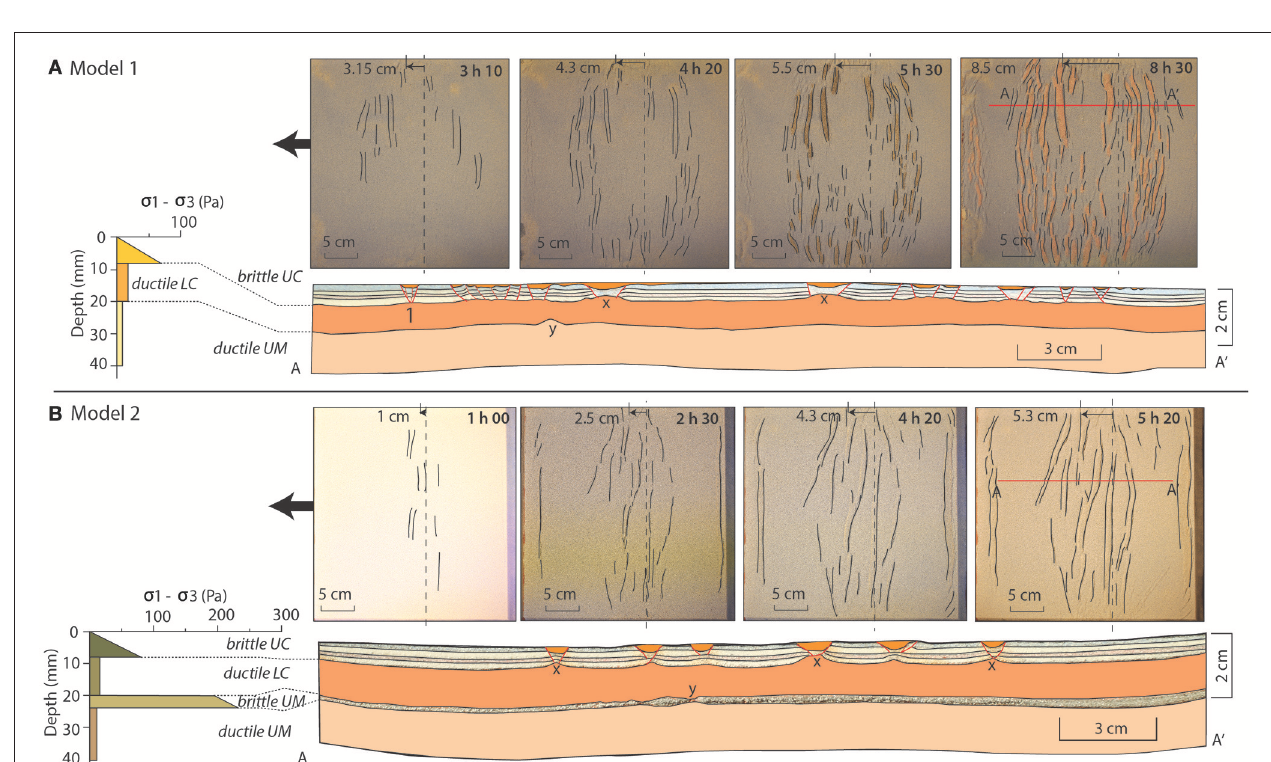
FIGURE 3 | Experimental results of models with one type of lithosphere (A) Model 1 (M1) and (B) Model 2 (M2). Wide rifts form in both models, M2 being 25% less wide than M1 due to the presence of a stronger sub-Moho mantle. Ductile lower crust is exhumed (locations x, M1, and M2). Moho topography shows subtle long wavelength undulations, generally not in phase with the graben structures indicating the flow of material. Pinch and swell structures form in the brittle lithospheric mantle of M2 (location y). The bracketed line on the top-view images represents the contact between the two lithospheric segments. BC, brittle crust; DC, ductile crust; BM, brittle mantle; DM, ductile mantle